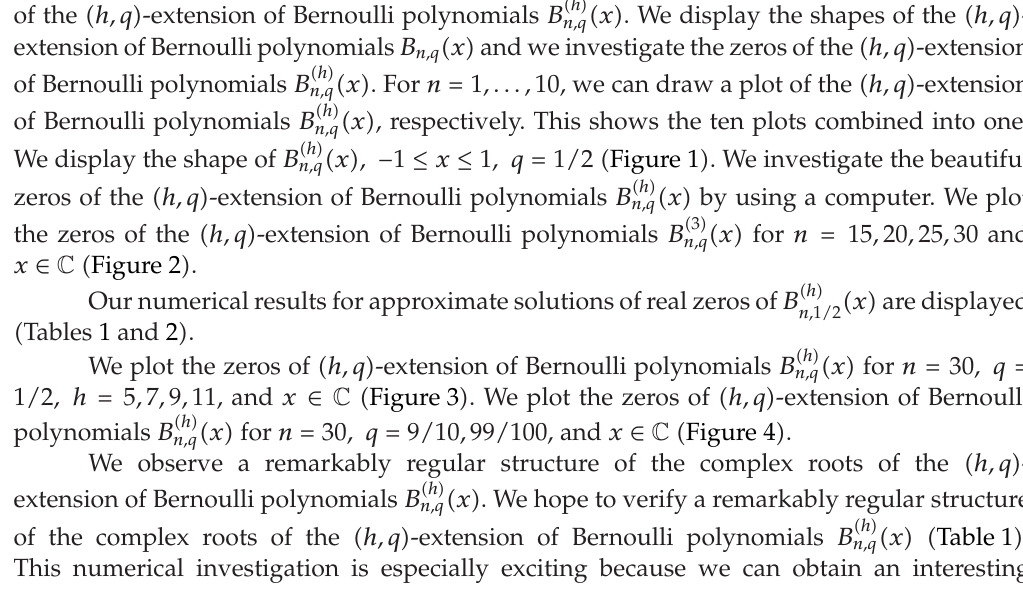
(cid:2) 3 (cid:3) (cid:2) x (cid:3) n, 1 / 2